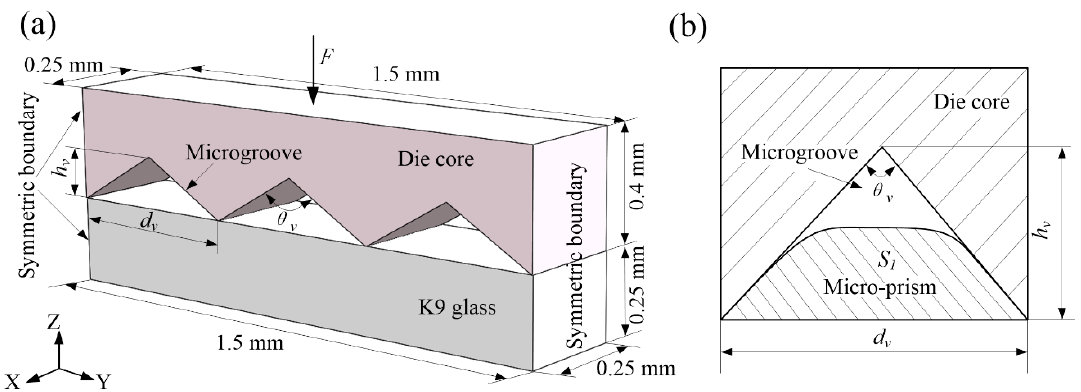
Figure 1. Simulation model of hot-embossing glass-microprism array: ( a ) physical-theory model; ( b ) formation of rate-calculation principle.